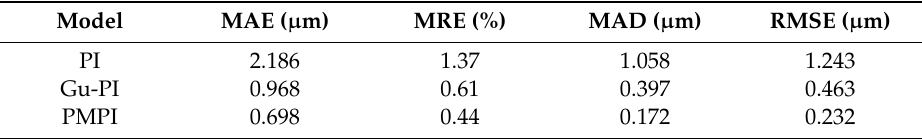
Figure 13. Performance comparison of three modeling methods in two cases. ( a ) Modeling errors in Case 1; ( b ) modeling errors in Case 2. Table 2. Comparison of three model errors in Case 1.